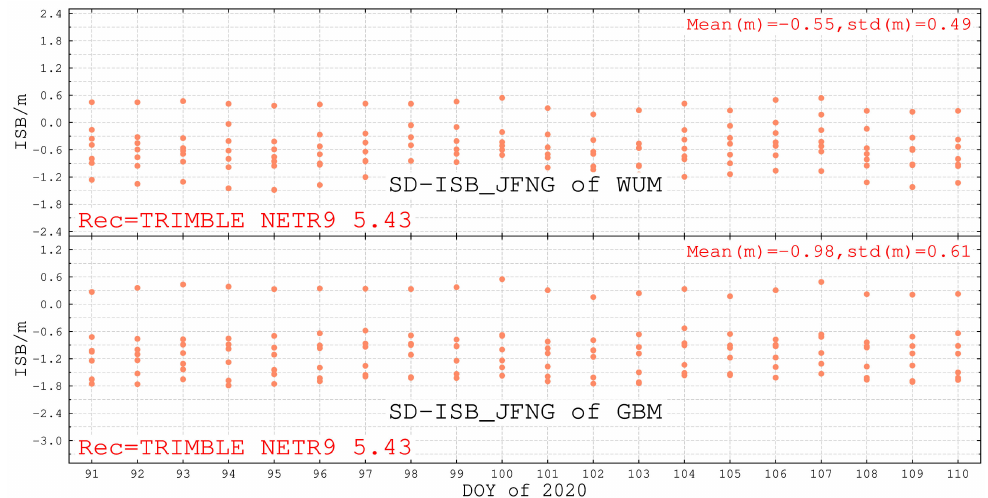
Figure 13. The single di ff erence ISB series of TRIMBLE NETR9 5.43 by using GBM and WUM precise products from DOY 091 to 110, 2020. Reference station: JFNG.